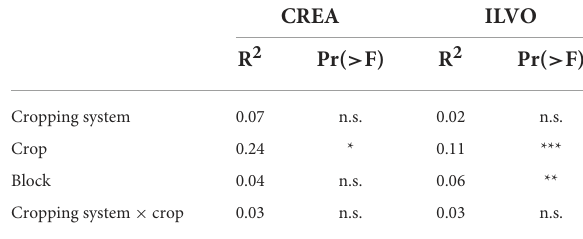
TABLE 3 Results of the PERMANOVA carried out on the CREA and ILVO dataset on selected fungal